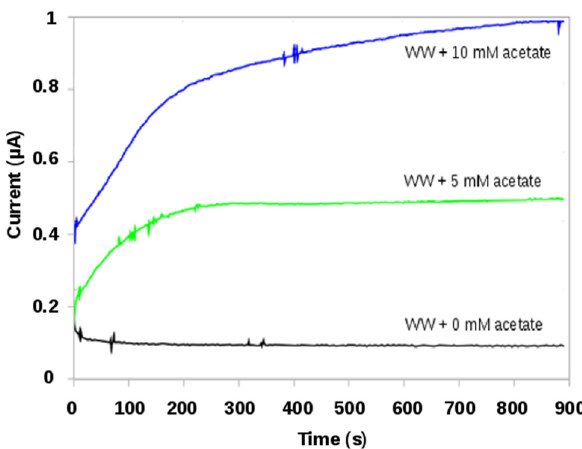
Figure 6. Current production of G. sulfurreducens from a real urban wastewater supplemented with 0 ( black ), 5 ( green ) and 10 mM acetate ( blue ). Working electrode was polarized a 0 V ( vs. Ag/AgCl).